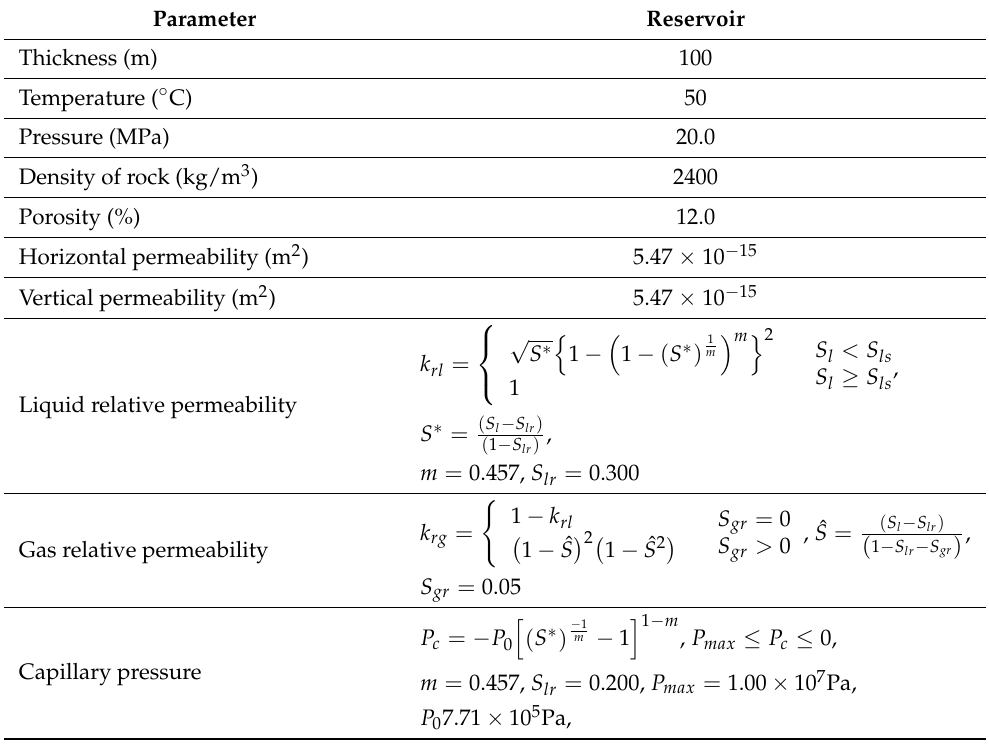
Table 1. Parameters of numerical model [22].